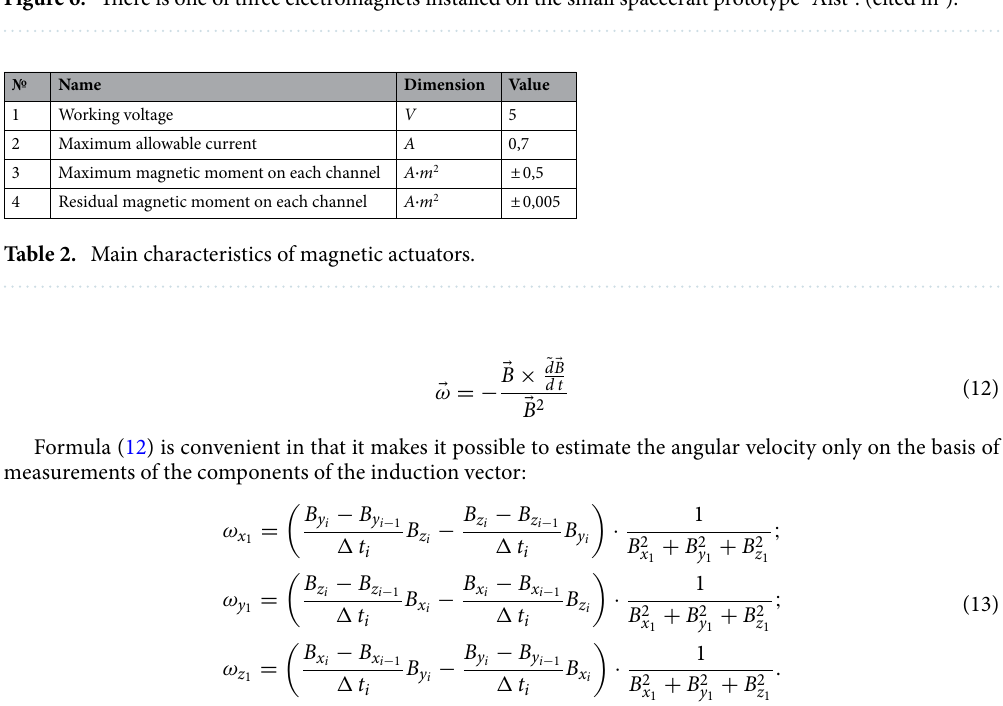
Figure 6. There is one of three electromagnets installed on the small spacecraft prototype "Aist". (cited in 4 ).